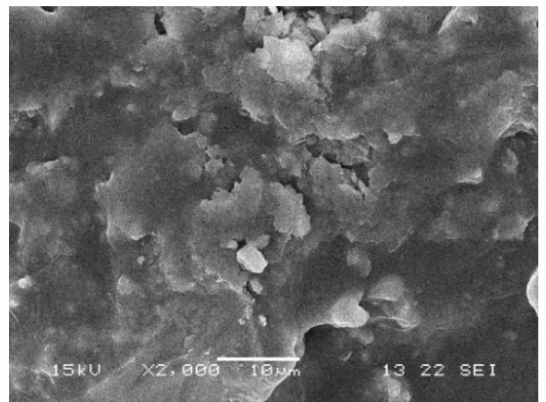
Figure 10. Microstructure of CEAM.